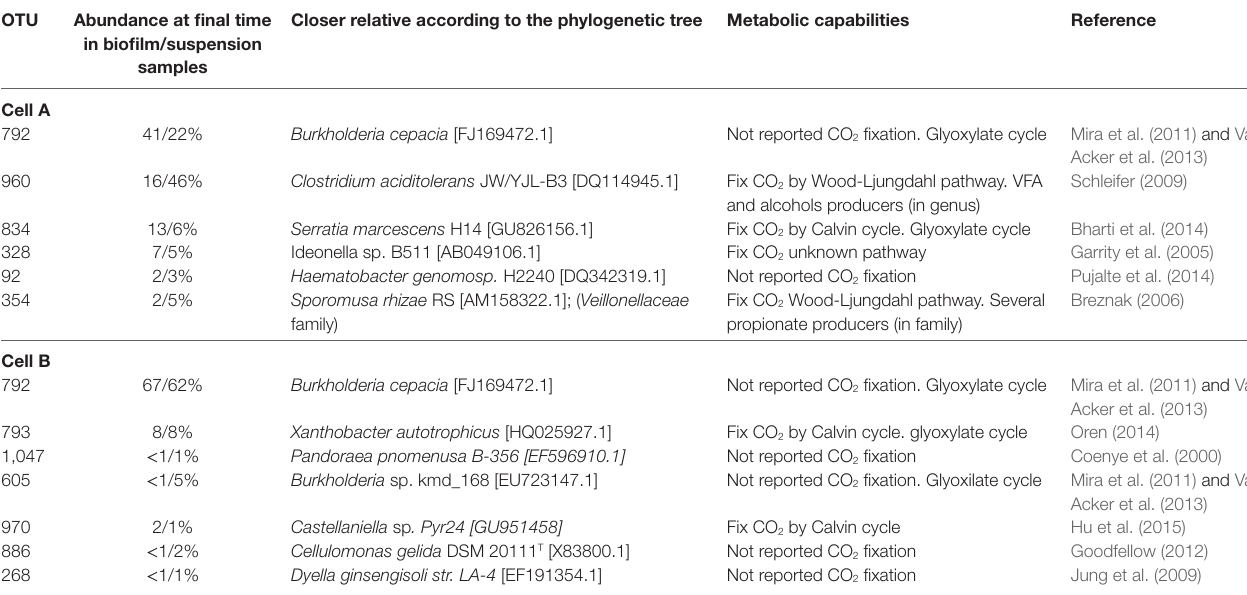
TaBle 2 | Classification of the predominant OTUs in the microbial communities according to 16S rRNA gene sequences analysis.